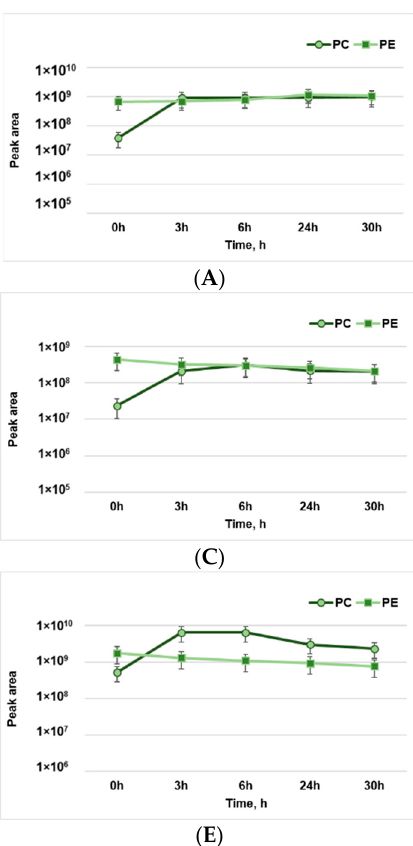
Figure 1. The dynamics of the formation of lipid oxidation products of phosphatidylcholine (PC) and phosphatidylethanolamine (PE): ( A )—pentanal; ( B )—hexanal; ( C )—octenal; ( D )—hydroxy-nonenal; ( E )—hydroxy-octadecanal.